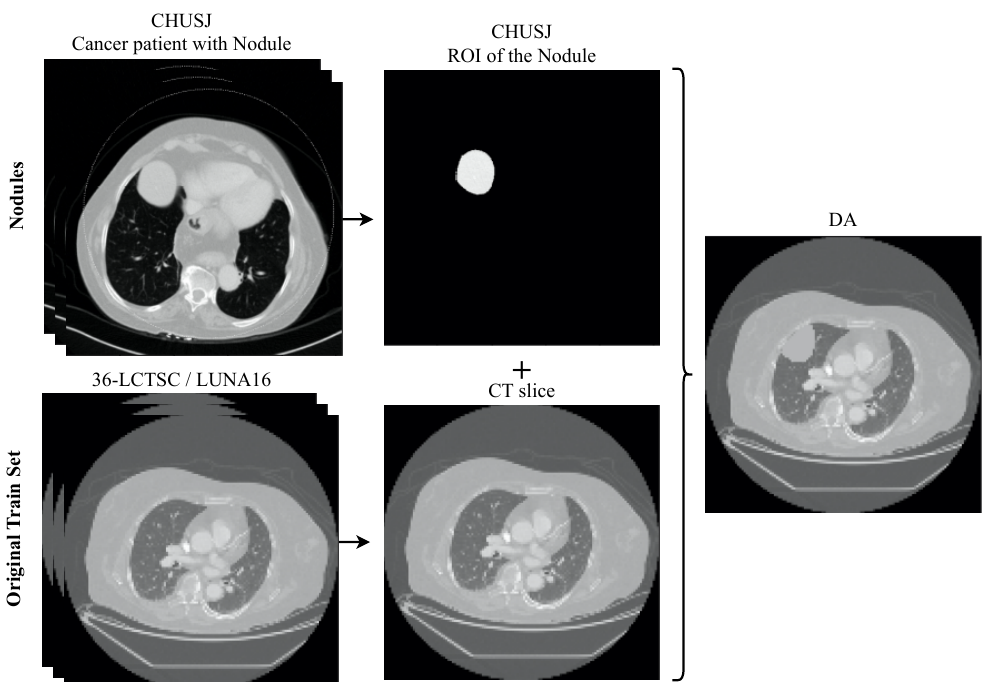
Figure 4. Overview of the process to generate the data augmentation. The nodules from the dataset CHUSJ were added to the original training set (36-LCTSC and LUNA16), creating new CT slices with multiple pathological imaging